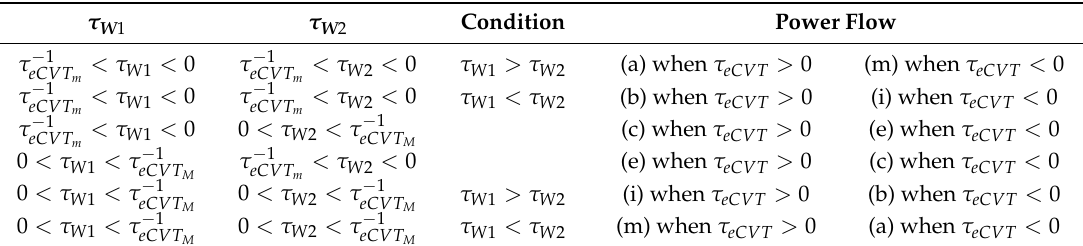
Table 7. Case 3—Power flows for each range of the planetary gear constants.